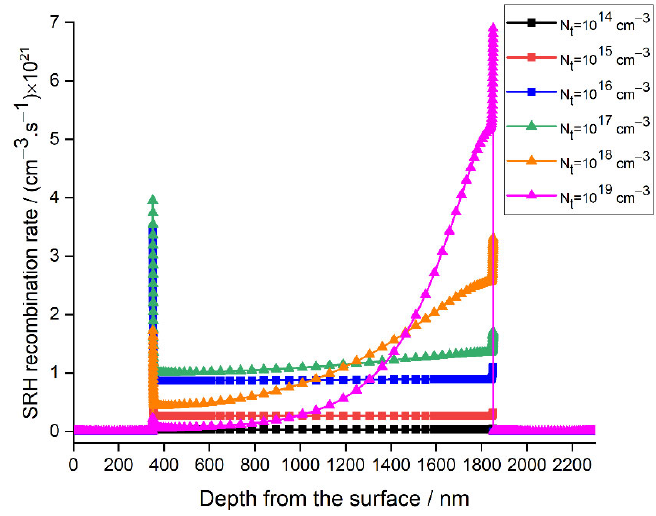
7 of 13 Figure 3. Photovoltaic characteristics of ( a ) 𝑃𝐶𝐸 , ( b ) 𝑉 (cid:3042)(cid:3030) , ( c ) 𝐽 (cid:3046)(cid:3030) and ( d ) 𝐹𝐹 as a function of the de ‐ fect density of the absorber layer. The perovskite defect density effect can be explained by the Shockley–Read–Hall (SRH) recombination model [64,65]. In this work, to clearly understand the defect density effect of the absorber on the performance of the device, the variation of the SRH recombi ‐ nation rate with depth from the surface for different values of defect density was studied